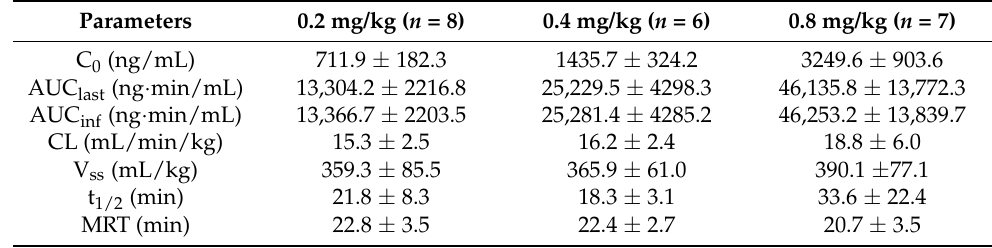
Table 2. Toxicokinetic parameters of β -amanitin in male ICR mice after intravenous injection of β -amanitin at three doses (mean ±